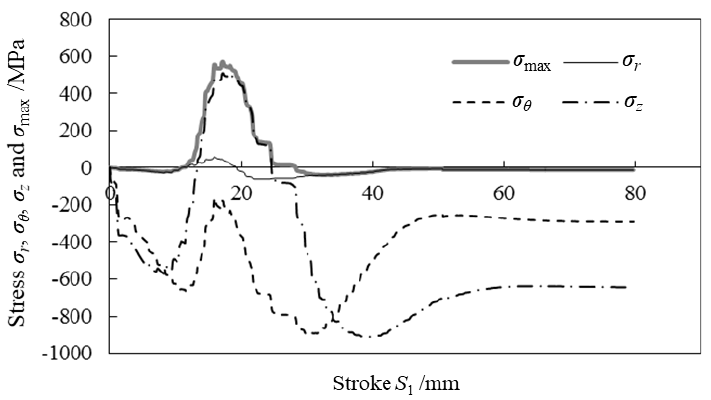
Figure 21. Stress variation in first forward extrusion.